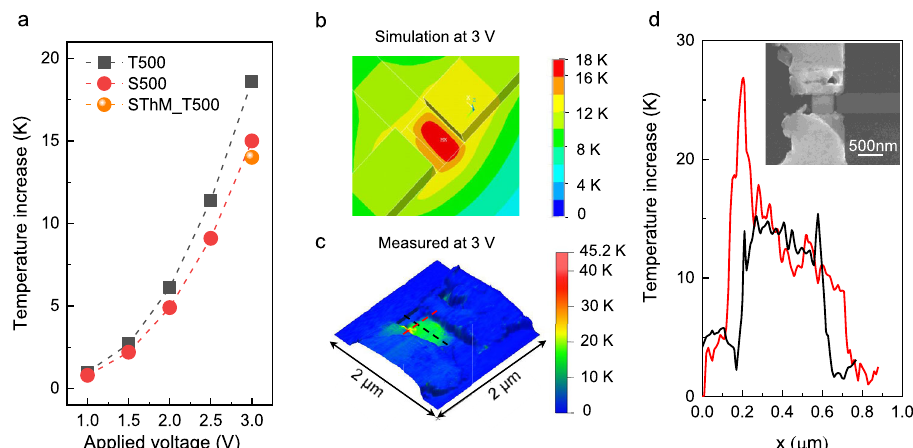
Fig. 3 Thermal characterization of a 500-nm T-shape device. a Temperature increase dependent on applied voltage (operating as emitter), the black squares show the simulation results of a T-shape device with device width of 500 nm (T500), the red dots show the simulation results of a straight device with device width of 500 nm (S500), the orange dot shows the scanning thermal microscopy (SThM) measured result on T500. b Simulated temperature distribution of the 500-nm T-shape device operating at 3 V. c SThM image showing topography and color-coded temperature rise of the device operating at 3 V. d Temperature pro fi le from SThM results along the black and red dashed line in c , inset: scanning electron microscope (SEM) image of the measured